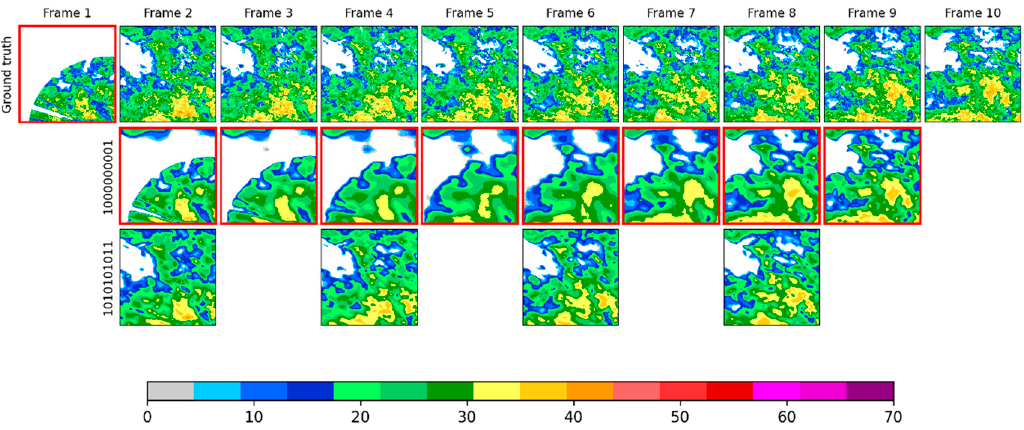
Figure 12. Examples of reconstructing missing radar frames with the CNN-BiConvLSTM model for missing patterns ‘1000000001’ (second line) and ‘1010101011’ (third line). The first line shows the input radar images (ground truths).